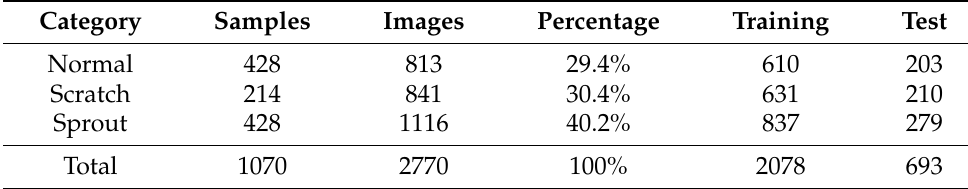
Table 2. Basic information of the potato surface defect